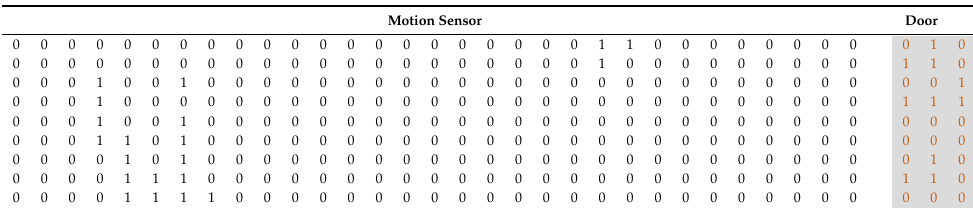
Figure 5. Sensor placement inside the experimental environment [28]. Table 2. Exemplar codes of sensor readings. Thirty-one bits are assigned by motion sensors, and three bits by door-closure